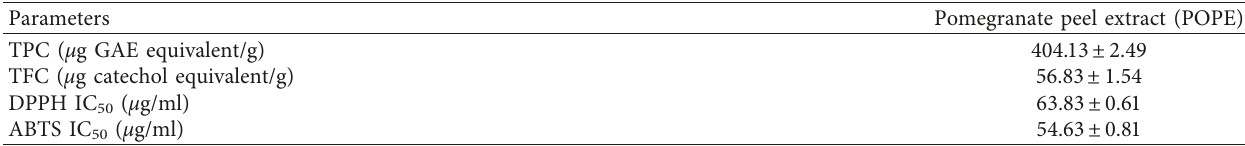
Table 1: Radical-scavenging activity (DPPH and ABTS), total phenolic content (TPC), and total flavonoid content (TFC) of pomegranate peel extract.